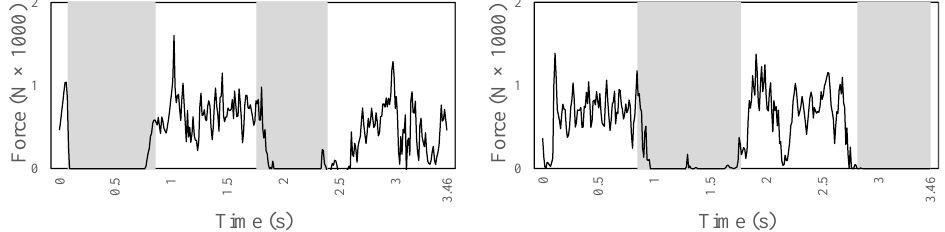
Figure 8. The ground reaction force in the Y direction computed at the zero moment point of each foot (left foot on the left and right foot on the right) during stair